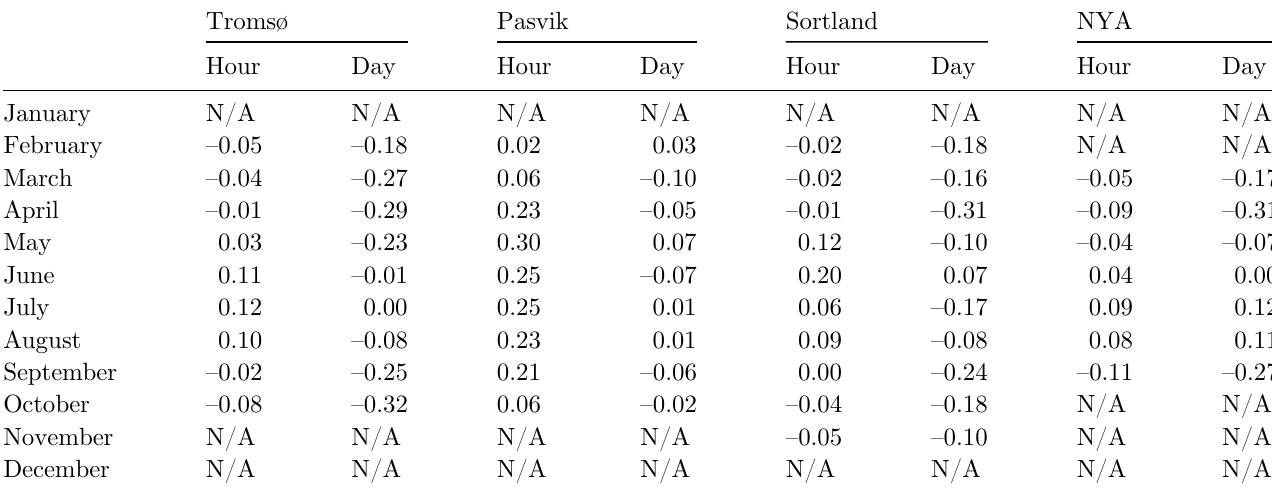
Table 2. Correlation coef fi cient for hourly and daily wind and solar energy for each month. The months with polar night are not considered to be